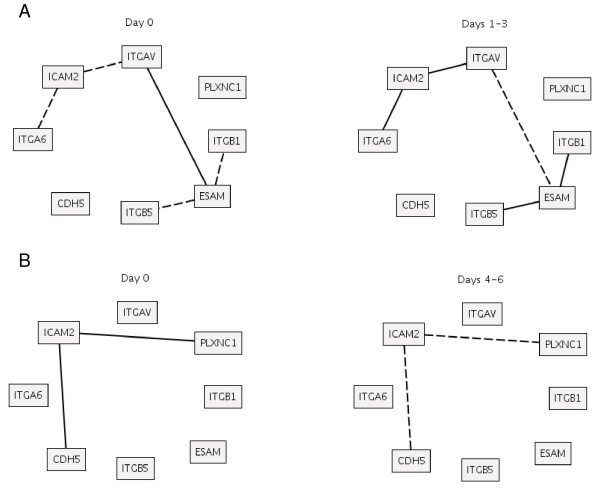
Relevance networks analysis. Relevance networks (p < 10-3). Changes in correlation between genes at day 0 (left panel) and days 1–3 (right panel) (A) and day 0 (left panel) versus days 4–6 (right panel) (B). Solid and dashed lines represent positive and negative correlation values, respectively.